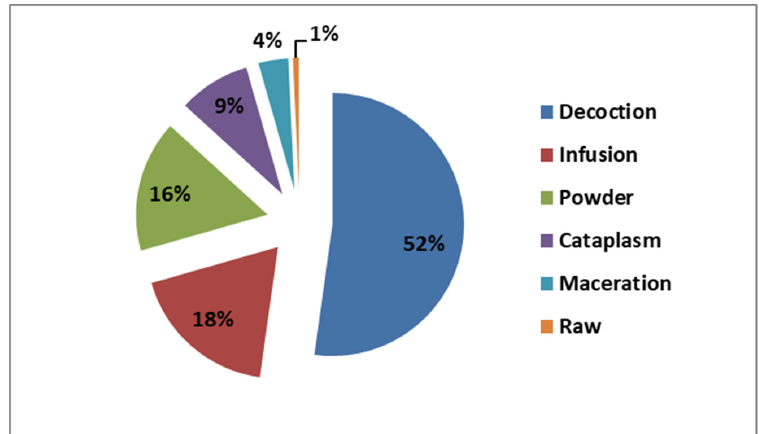
Figure 5. Percentage use of various preparations methods of plants against